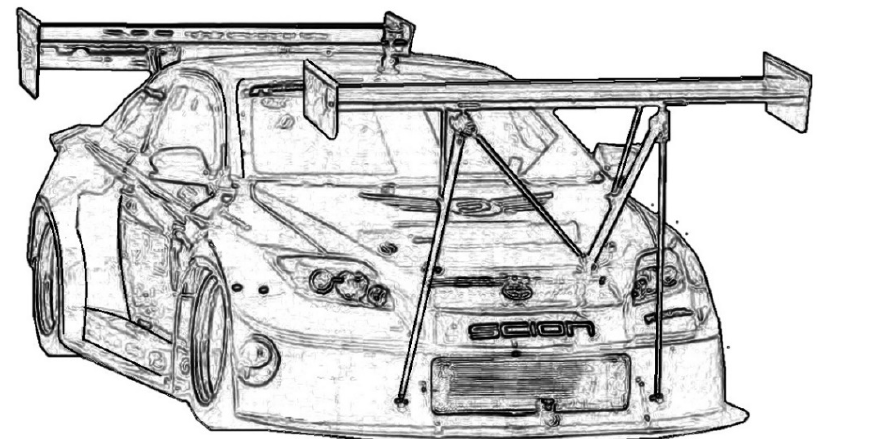
Figure 2. Scion with high front wing.